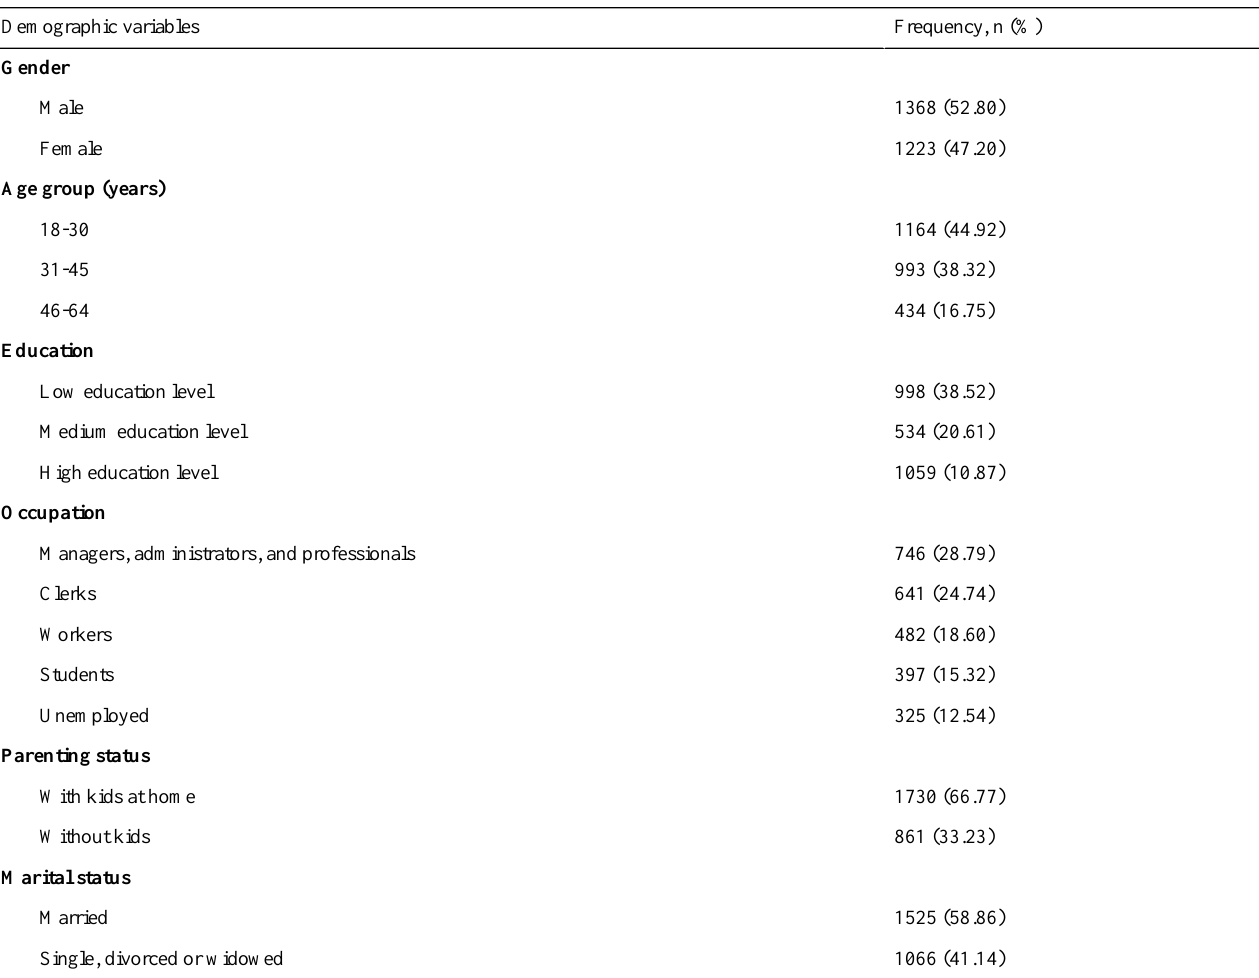
Table 1. Descriptive statistics of demographic variables (N=2591).